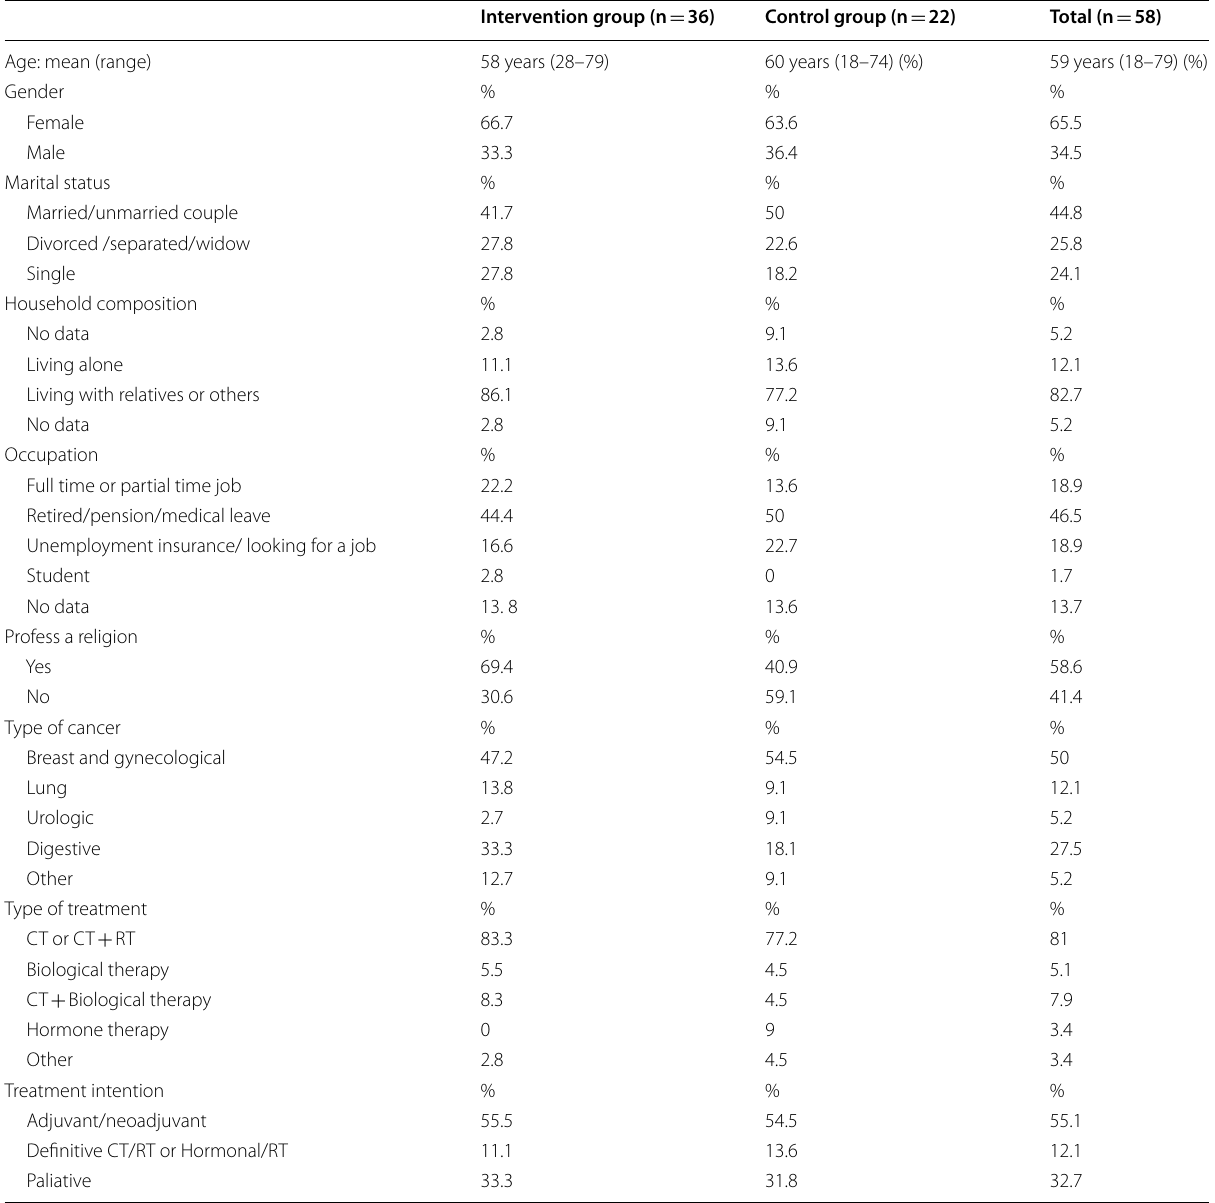
Table 1 Sociodemographic and clinical